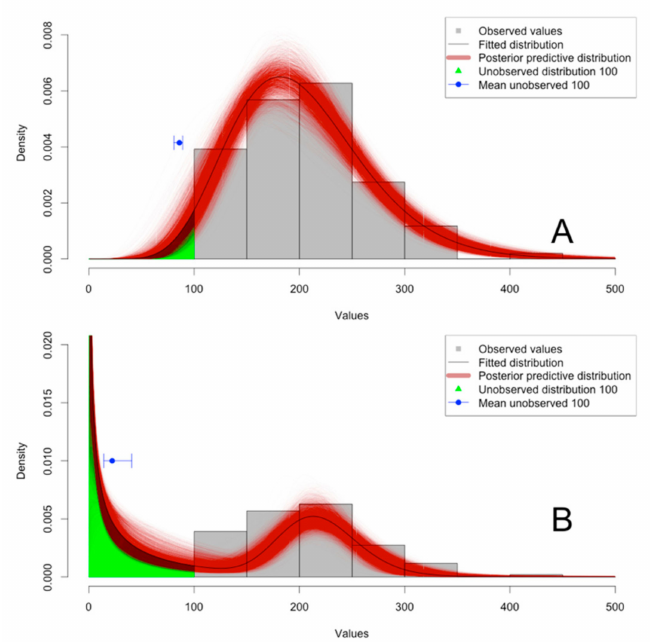
Figure 3. Observed distribution of the fictive set of censored left (LDL = 100) data with the corre- sponding fitted model for one ( A ) or two ( B ) gamma distributions. The model uses truncated data in A and censored data in B to demonstrate the information shared by the lower detection limit (LDL) observations. Posterior predictive distribution based on 5000 Markov chain Monte Carlo iterations are shown along with the mean and 95% credible interval for the values below the